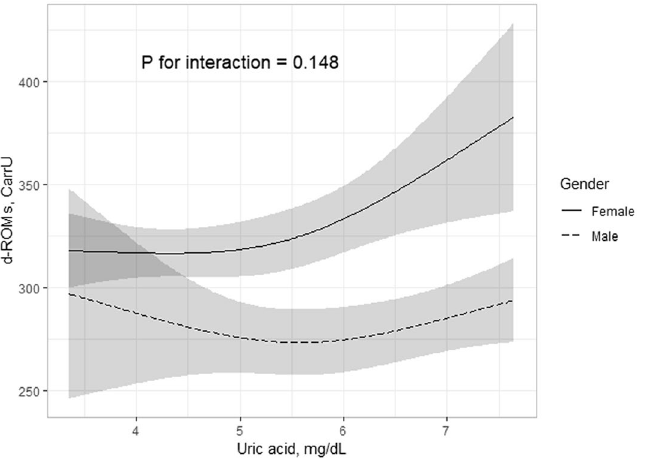
Figure 3. Serum uric acid and d-ROMs levels stratified by gender. The serum level of uric acid was significantly associated with d-ROMs level in females ( p = 0.036) but not in males ( p = 0.115). The nonlinear effect of serum uric acid level on d-ROMs level was significant ( p = 0.066). Best fitted line and 95% CI results are shown by a solid line and dark gray band, respectively. Values for d-ROMs were adjusted according to the median values for age, smoking habit, alcohol drinking habit, VFA, SBP, total cholesterol, HbA1c, eGFR, log HOMA-IR, log hs-CRP, and log plasma XOR activity after stratification by gender. d-ROMs derivative of reactive oxygen metabolites, CI confidence interval, VFA visceral fat area, SBP systolic blood pressure, HbA1c glycated hemoglobin, eGFR estimated glomerular filtration rate, HOMA-IR homeostatic model assessment of insulin resistance, hs-CRP high-sensitivity C-reactive protein, XOR xanthine